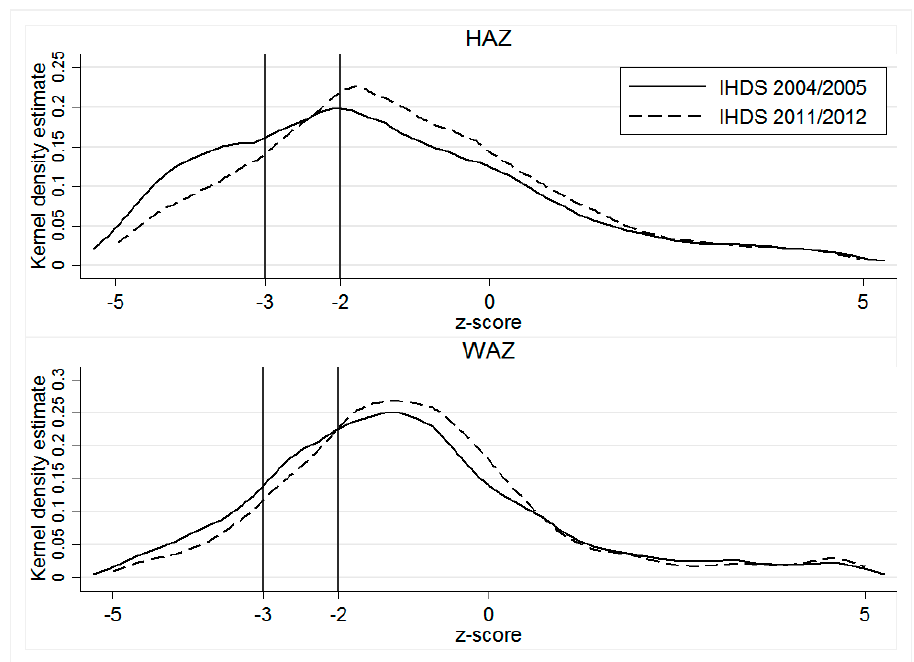
Figure 1. Kernel density estimates for HAZ and WAZ by year. Notes: Kolmogrov–Smirnov test p -